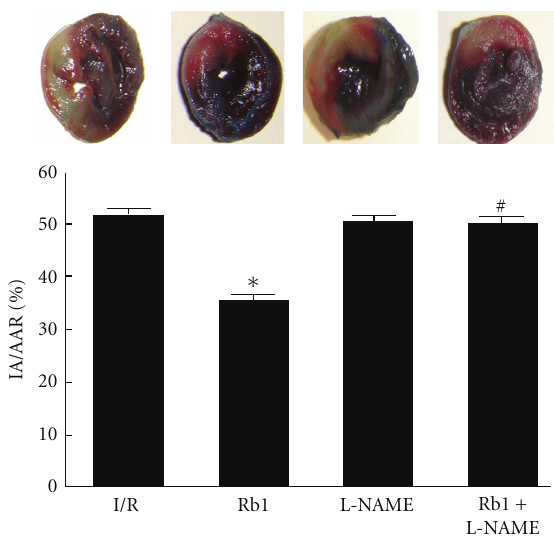
Figure 1: Infarct size expressed as percent of the area at risk in rats subjected to 30 min ischemia and 2 h of reperfusion. The blue- stained areas represent nonischemic tissue and red-stained areas represent the area at risk. Pale areas indicate infarct areas. Results are expressed as mean ± SEM. n = 6, ∗ P < 0 . 01 versus I/R group, # P < 0 . 01 versus Rb1